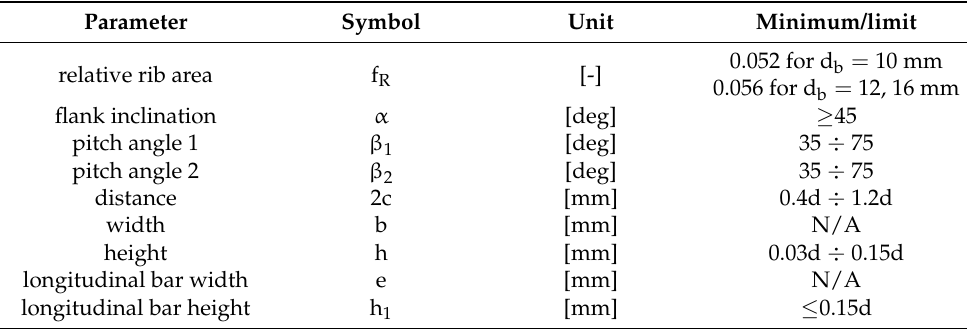
Figure 3. Parameters of deformed steel reinforcing bar B500SP [41] and its actual appearance. Table 4. Properties of deformed steel reinforcing bars B500SP [41].